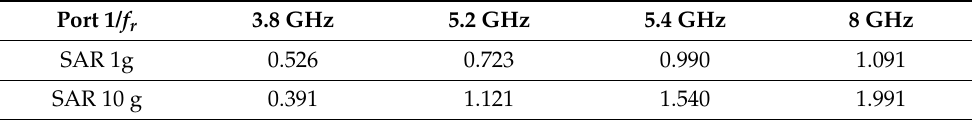
Table 5. Maximum SAR values (W/kg) at each